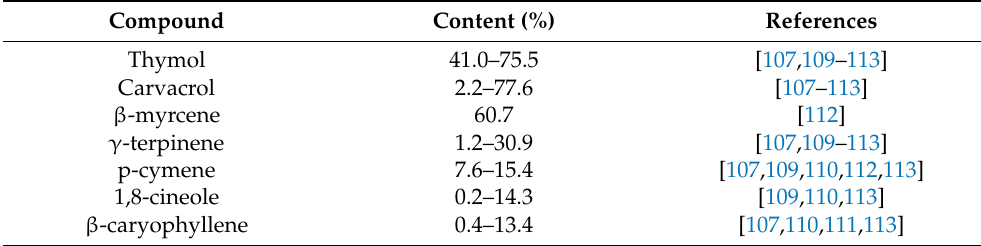
Table 6. Prevailing components of T. vulgaris essential